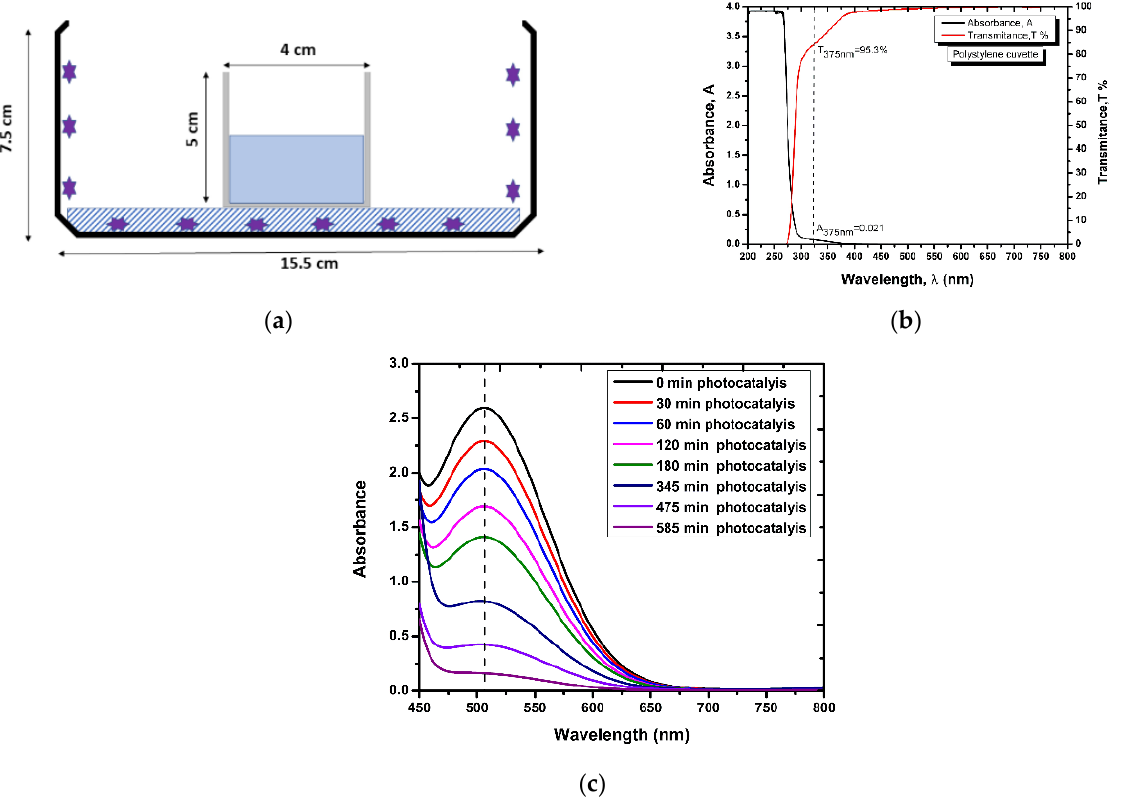
Figure 2. ( a ) Schematic diagram and dimensions of batch photoreactor with the UV-oven of 22 W ( b ) UV-Vis absorption spectrum of polystyrene cuvette. ( c ) UV-Vis spectrum of phenol degradation as a function of time detected by 4-aminoantipyrine method.